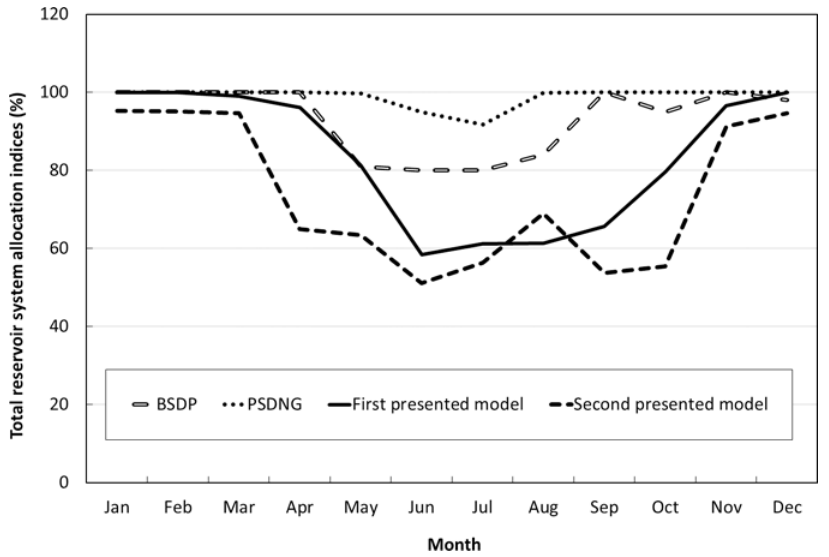
Fig 8. The volumetric reliability of the reservoir system associated with different models for Zayandeh-Rud river system.